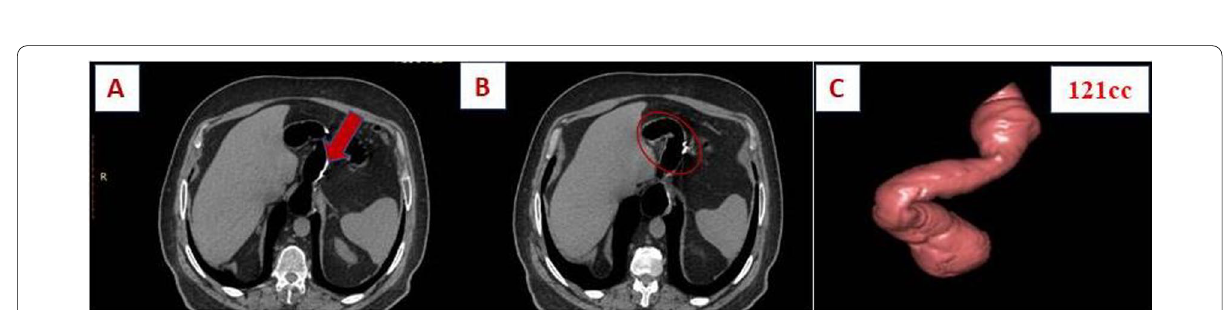
Fig. 6 A 41‑year‑old obese male (BMI 43.7) with postoperative gastric volume is 121 cc. Preoperative weight and 1‑year postoperative were = 119 kg and 72 kg, respectively. Weight reduction percentage is 39.5%, and 1‑year postoperative BMI is 26.4. % of loss from the excess weight A, B CT abdomen are showing staples (arrow) and gastric pouch (circle). C 3D CT gastric volumetry showing gastric volume of 121